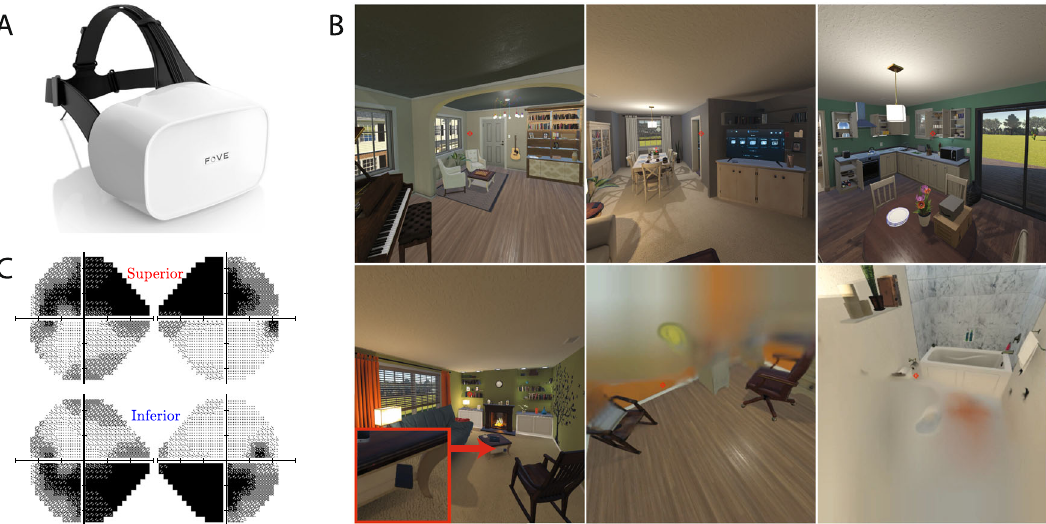
Fig. 2 VR search task methods. a Hardware: The Fove0 VR headset with integrated eye tracking, which was worn throughout. b Task: Example screenshots from the VR simulator, while performing the Object Search task. Virtual rooms were con fi gured into a complete ‘ suburban style ’ house. Depending on the player location, it was often possible to see into other rooms, connecting hallways, etc. For added realism the outdoor scenes were also rendered and could be seen from those rooms with external windows (see top-right panel). On each trial, the target phone (highlighted in the bottom-left panel) was placed at a random location. Examples of the superior and inferior VFL (right- eye only) are depicted in the bottom-middle and bottom-right panels, respectively (NB: the red crosshair indicates current their point of fi xation and was not visible to participants). c The empirical perimetric data used to generate the simulated VFL. The superior fi eld-loss measurements were made using Static Automated Perimetry, using a single observer with an established diagnosis of glaucoma (see Methods). The inferior loss is the exact mirror inverse of the superior. See Supplementary Video 2 for an example trial.